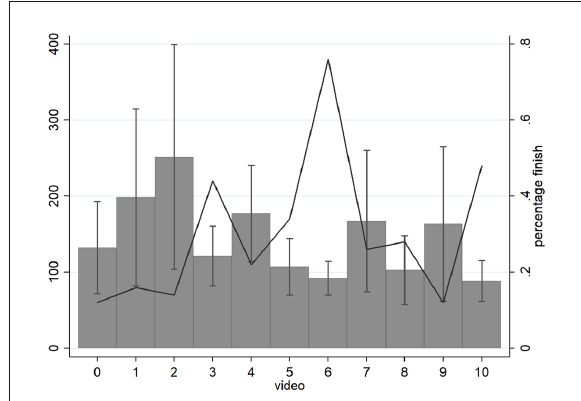
FIGURE5 Average Acceleration during videos was 23.8% higher for those who donated money compared to those who did not donate ( p = 0.011). Bars are SEs.